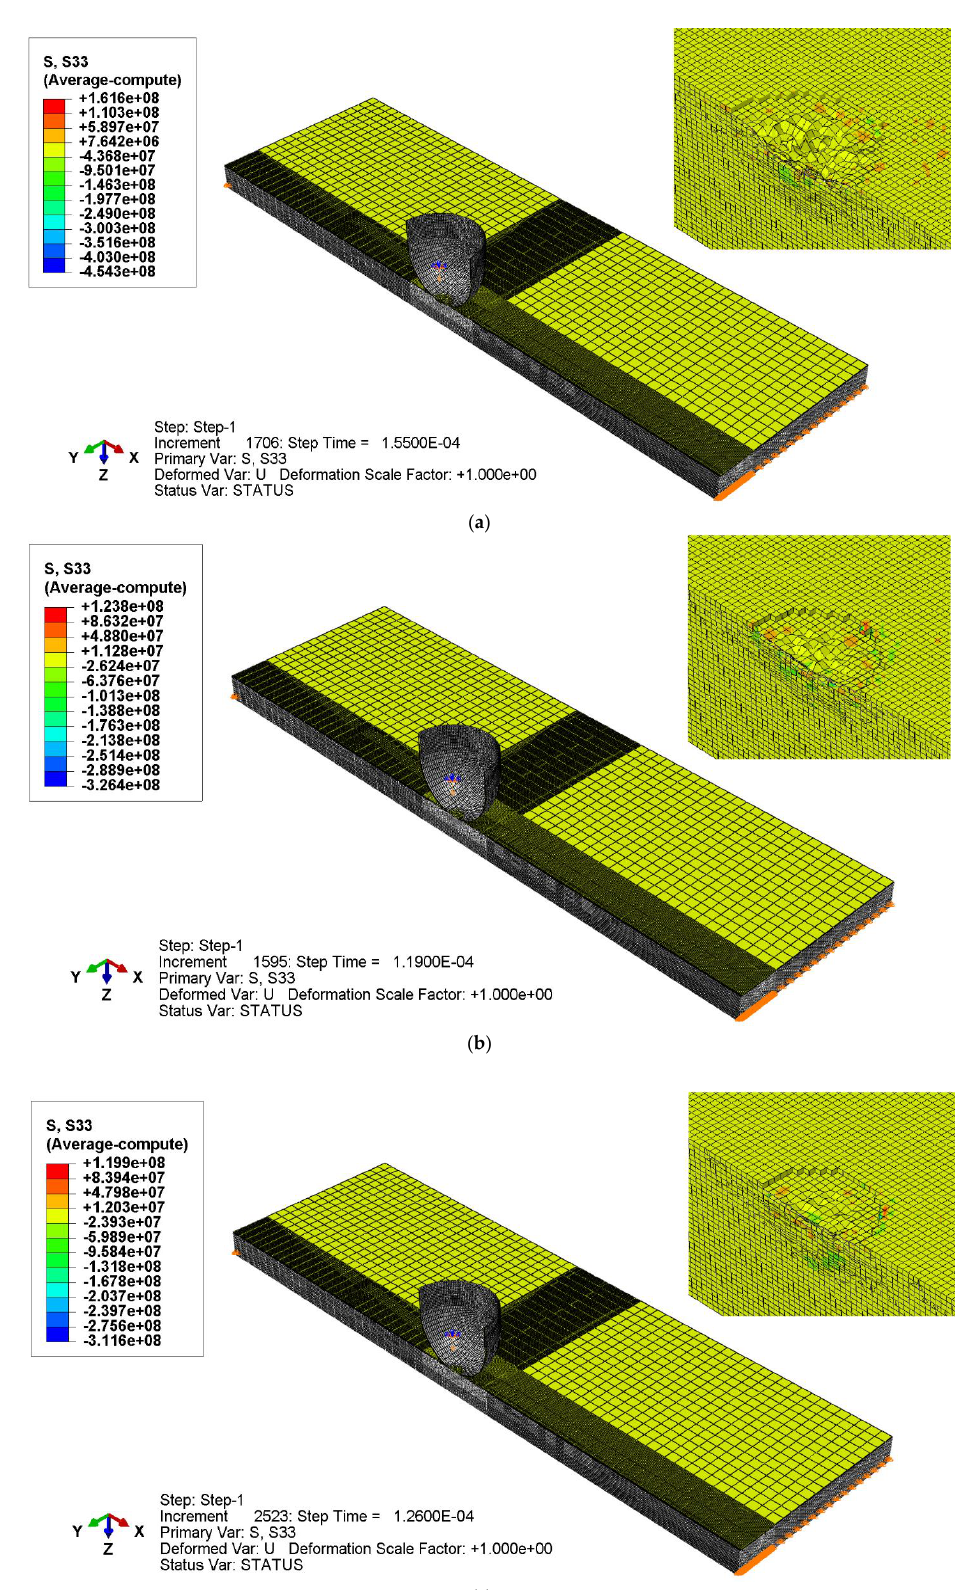
Figure 12. 𝜎 33 (stress distribution in z-direction) for three impact energy cases: ( a ) 𝜎 33 for 50 J im- Figure 12. σ 33 (stress distribution in z-direction) for three impact energy cases: ( a ) σ 33 for 50 J impact pact case; ( b ) 𝜎 33 for 40 J impact case; ( c ) 𝜎 33 for 30 J impact case. case; ( b ) σ 33 for 40 J impact case; ( c ) σ 33 for 30 J impact